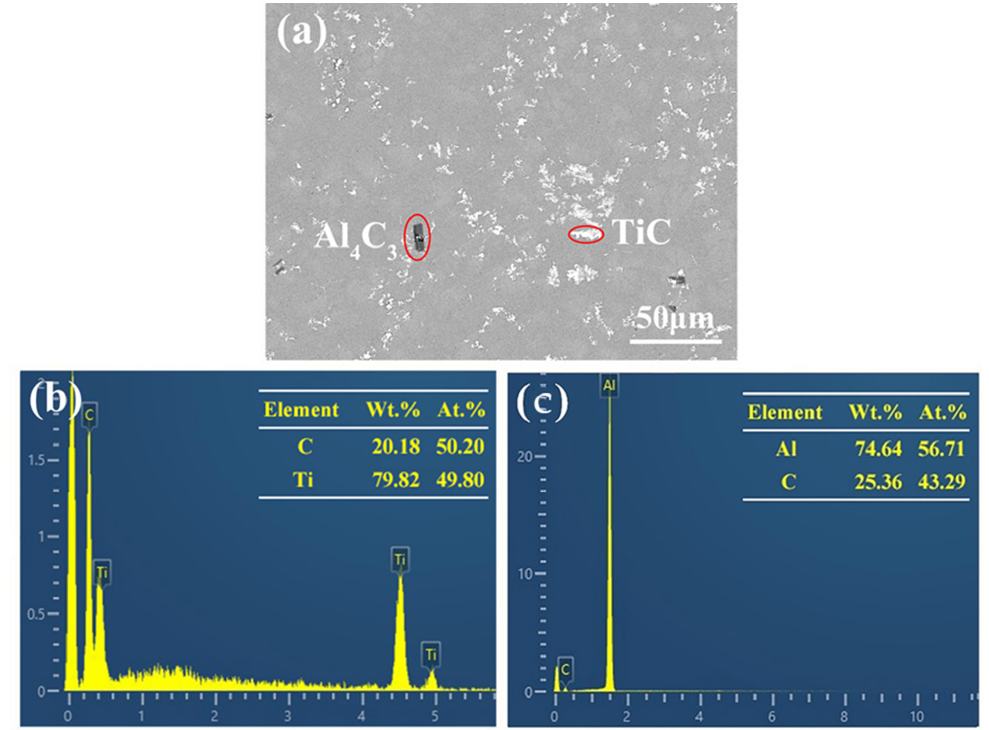
Figure 5. EDS point analysis of Al-4Ti-1C composites prepared by 30 μ m graphite: ( a ) microstructure and ( b , c ) corresponding EDS point analysis results.